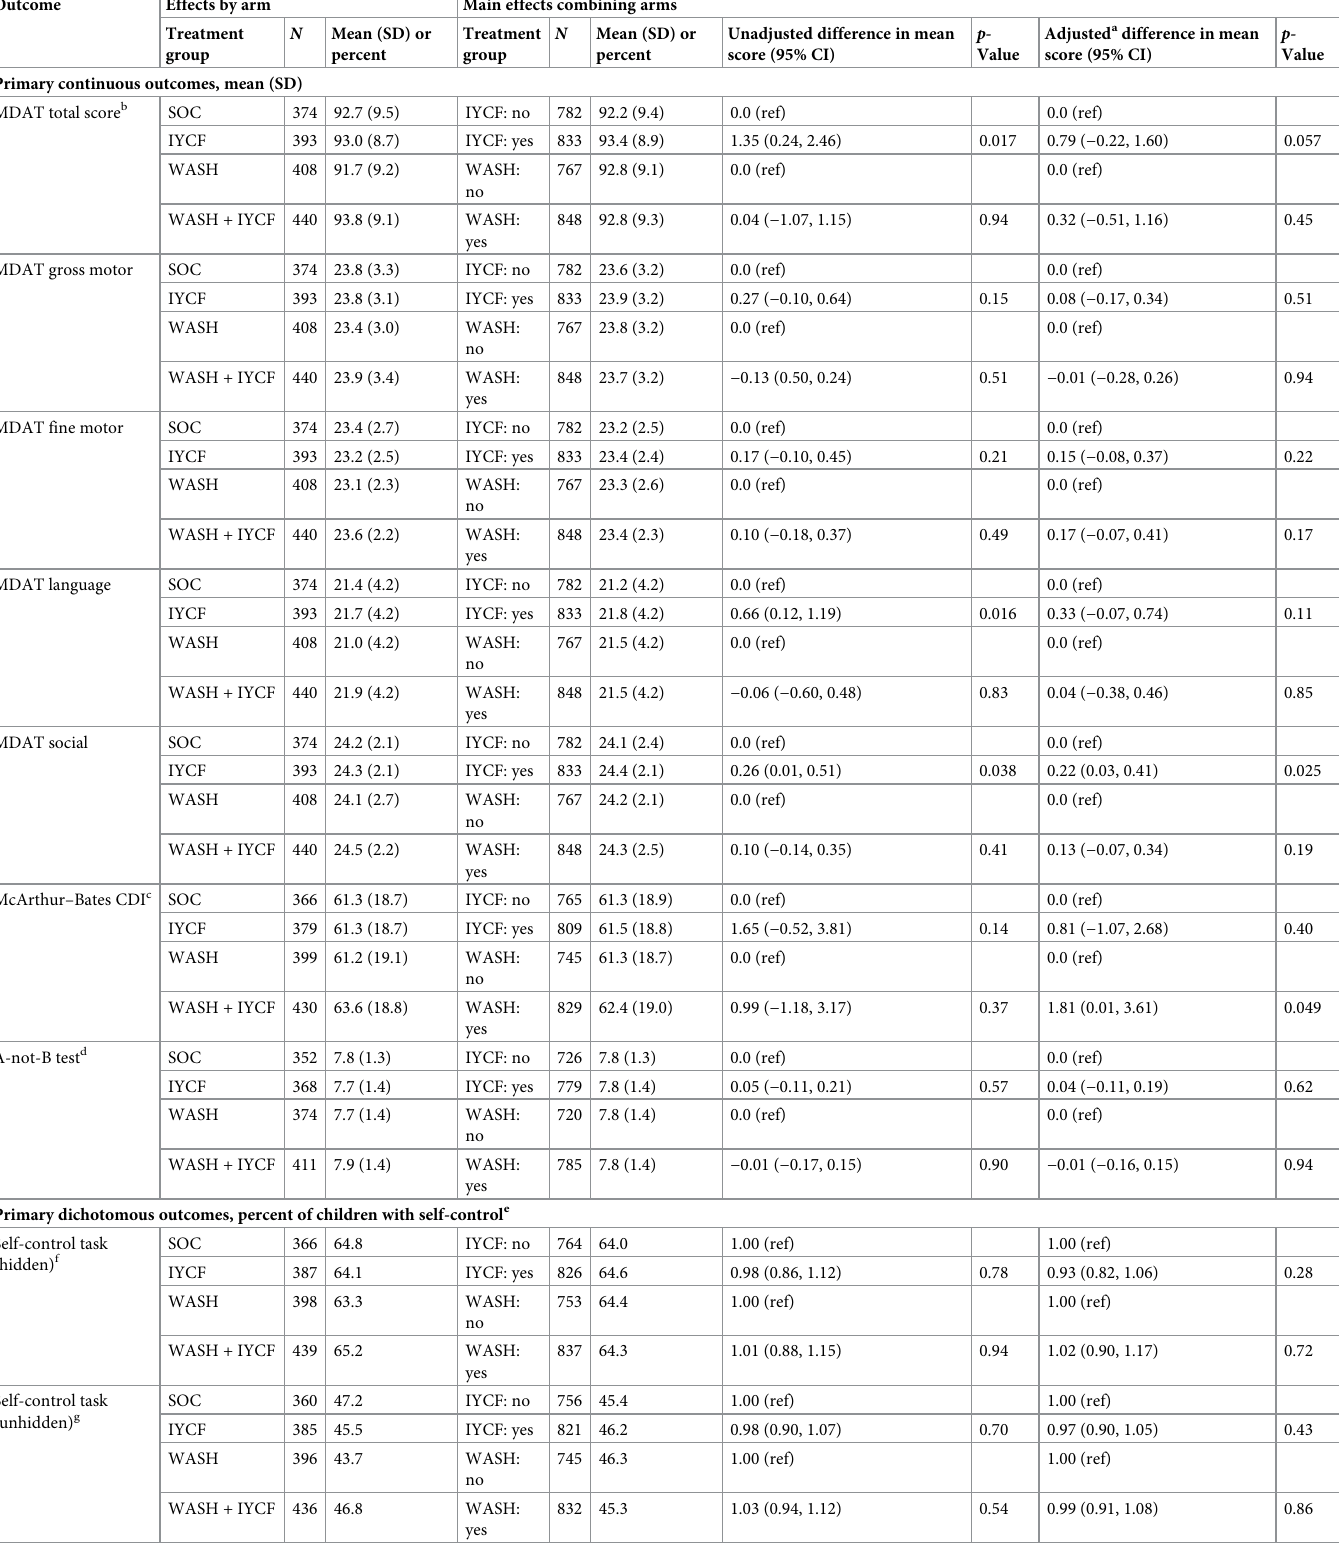
Table 4. Effect of WASH and IYCF interventions on early child development at 24 months of age.